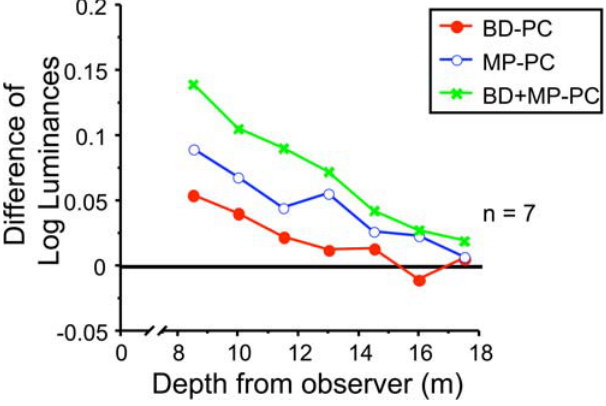
Figure 8. Depth Cue Effects without Pictorial Cues. Motion Parallax and Binocular Disparity. The effect of motion parallax alone, binocular disparity alone, and both motion parallax and binocularly disparity on luminance settings with the effect of pictorial cues subtracted.